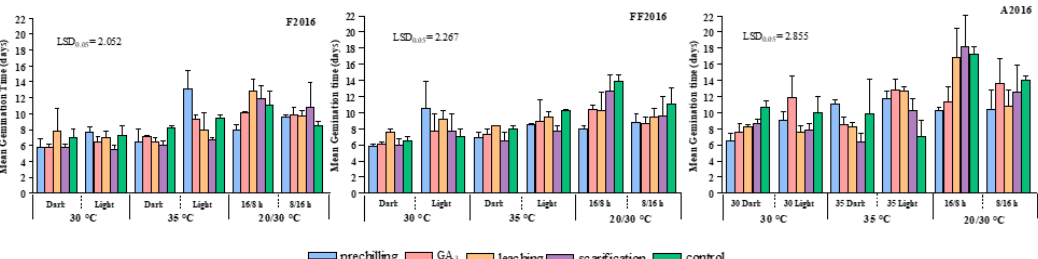
Figure 3. Effect of the interaction (A × B) between different pre-germination treatments (A) and temperature/light conditions (B) on mean germination time (MGT) of P. incarnata F2016, FF2016, and A2016